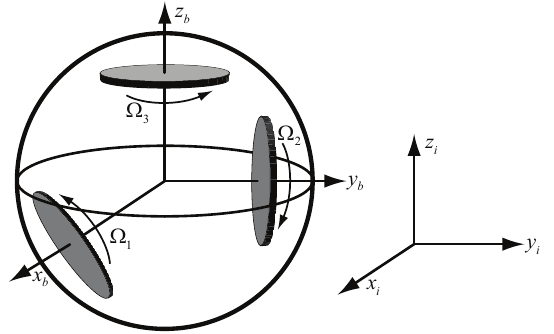
Figure 1: Illustration of the AUVSAT where the iner- tial { i } and body { b } coordinate frames are shown as well as the reaction wheel rates Ω